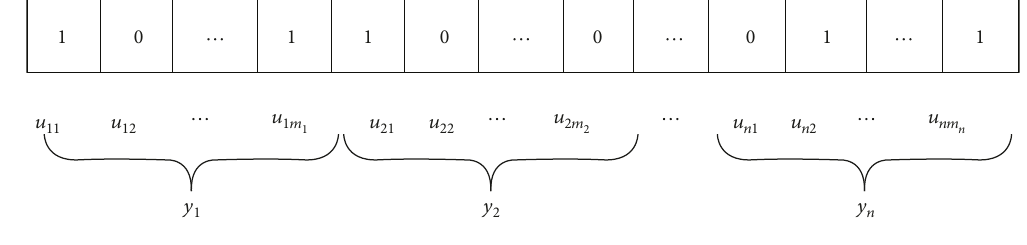
Figure 5: Encoding